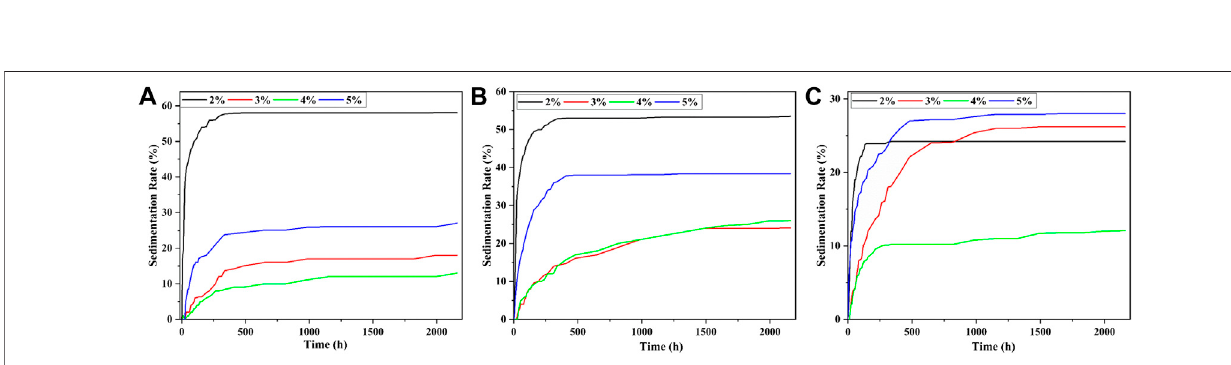
FIGURE 8 | The settling rate when the surfactant is stearic acid; the mass fraction of CI was (A) 40%, (B) 50%, and (C) 60%.